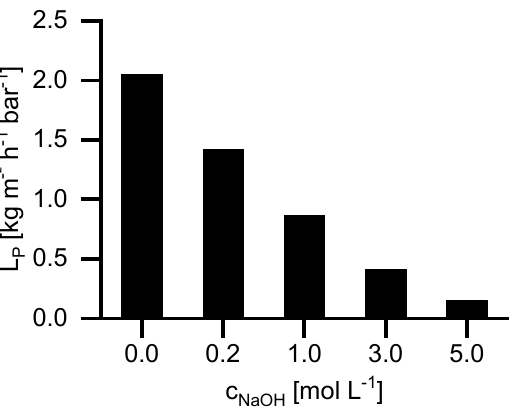
Figure 3. Permeability coefficient ( L P ) of water and NaOH solutions of different concentrations at 40 °C.